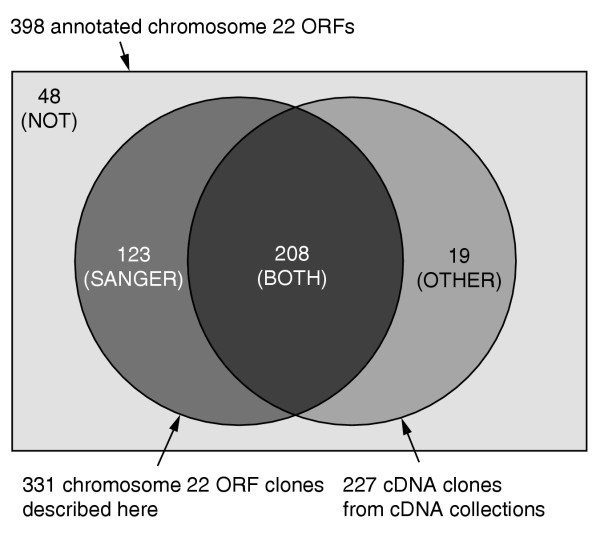
Schematic Venn diagram showing the relationships of the set of ORF clones isolated here compared with the full-length cDNA clones in current high-throughput clone collections (227 maintain the correct reading frame at the amino acid level from Table 1) for the 398 annotated full-length chromosome 22 ORFs. The four different classes of genes are labeled as in the text and Figure 2b.